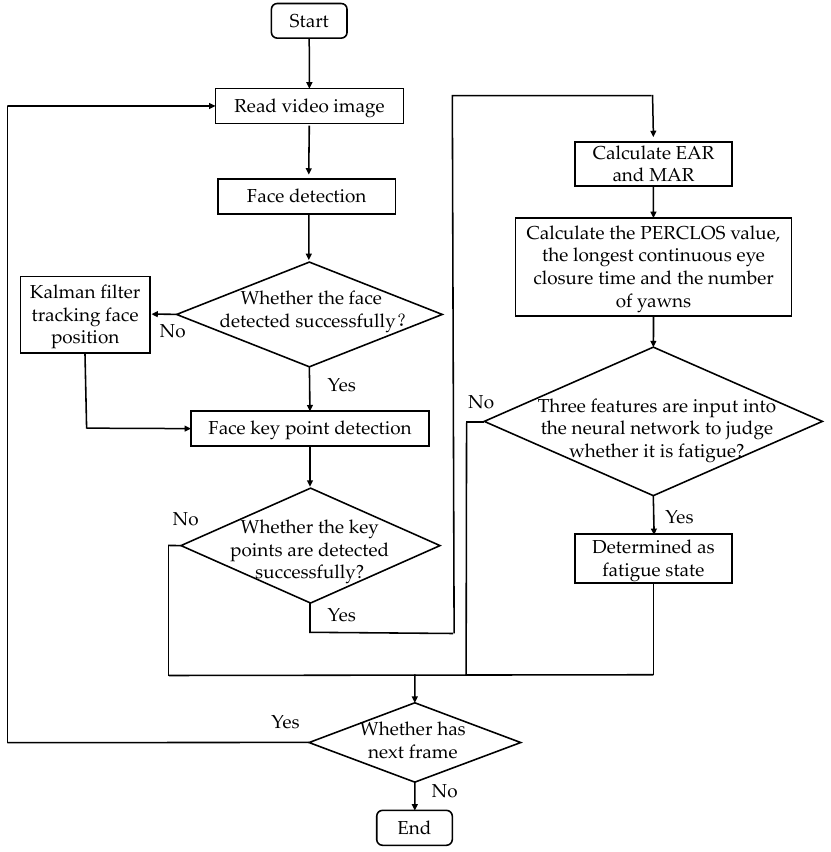
Figure 6. Flow chart of fatigue driving detection based on the BP neural network model.